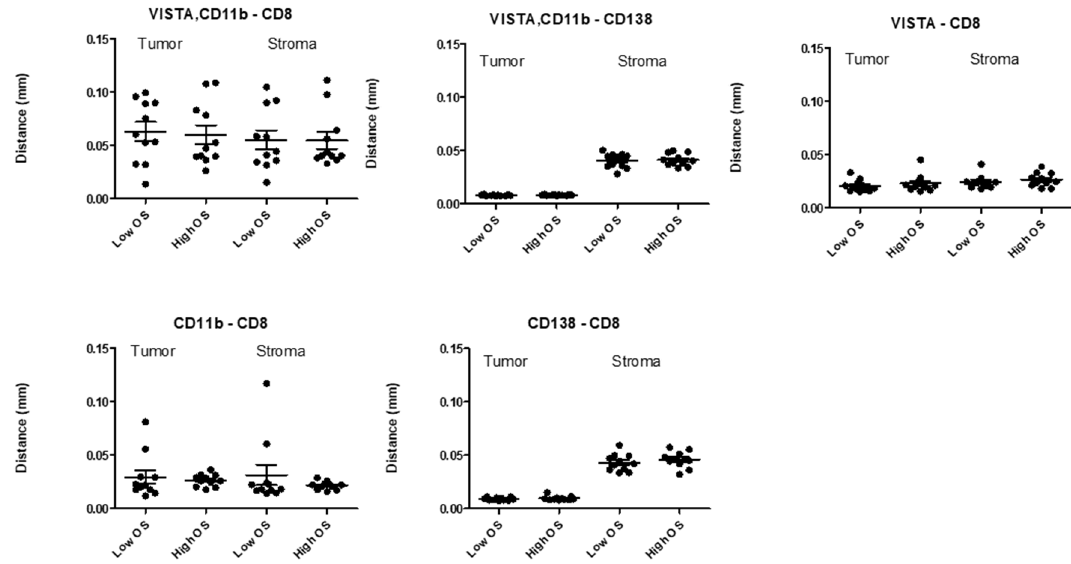
Figure 5. Distances between immune cells, including VISTA+, CD11b+ cells and CD8+ T-cells, do not differ between MM patients with low and high OS. Scatter plots of distances between cells (x-axis) and CD8 T-cells in tumoral and stromal compartments of bone marrows from patients ( n = 22) with low versus high OS. OS was separated according to median value; and lines indicate mean +/ − SEM distances.